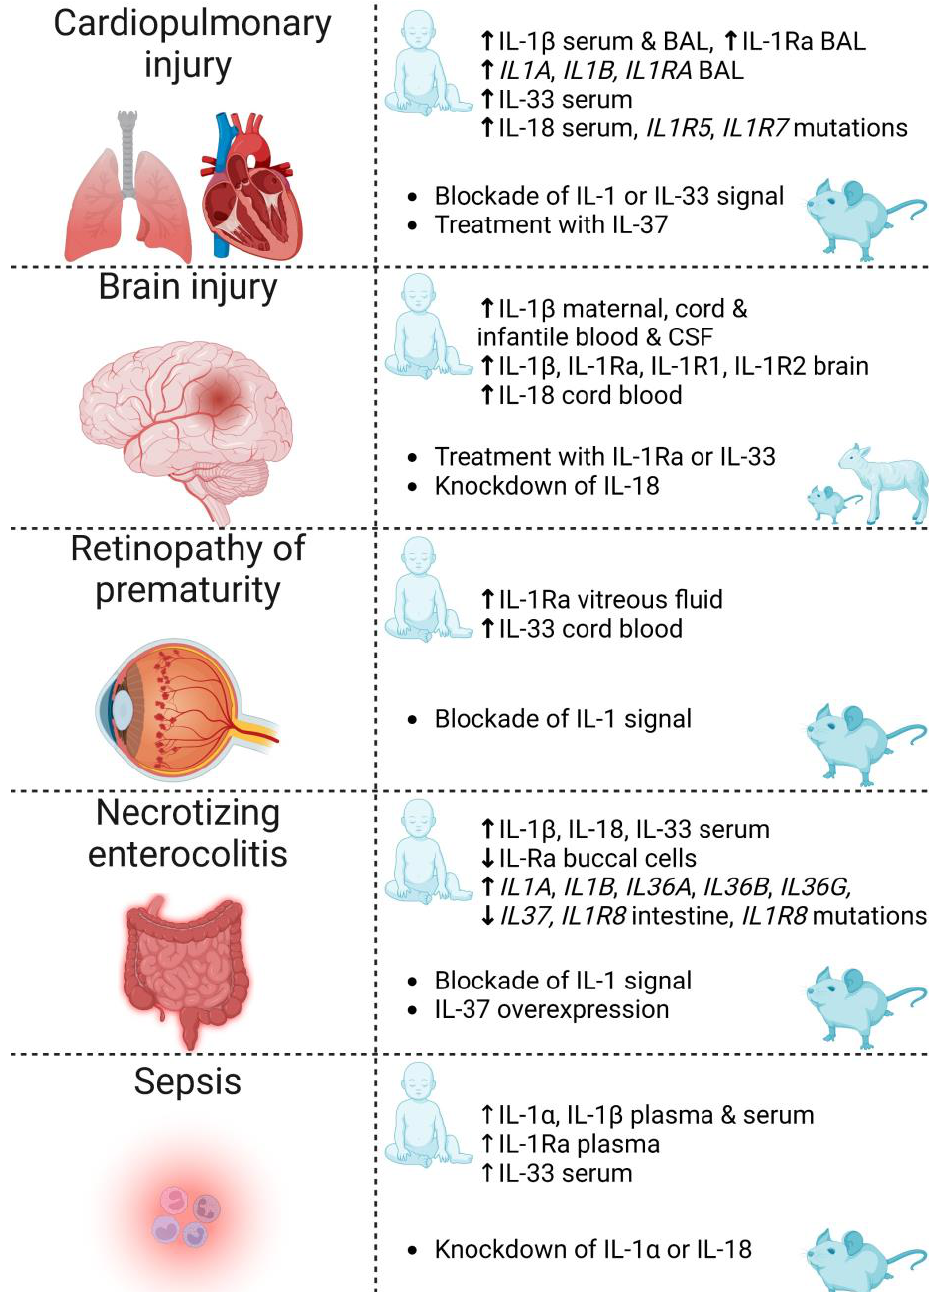
Figure 3. Summary of IL-1 family cytokines and receptors discussed in this review for which there is evidence of involvement in the complications of prematurity: cardiopulmonary injury, brain injury, retinopathy of prematurity, necrotizing enterocolitis and sepsis. Reported evidence includes clinical associations (human infant) and therapeutic strategies investigated in animals (rodents and sheep). IL — interleukin; BAL — bronchoalveolar lavage; Ra — receptor antagonist; CSF — cerebrospinal fluid. Created with biorender.com.